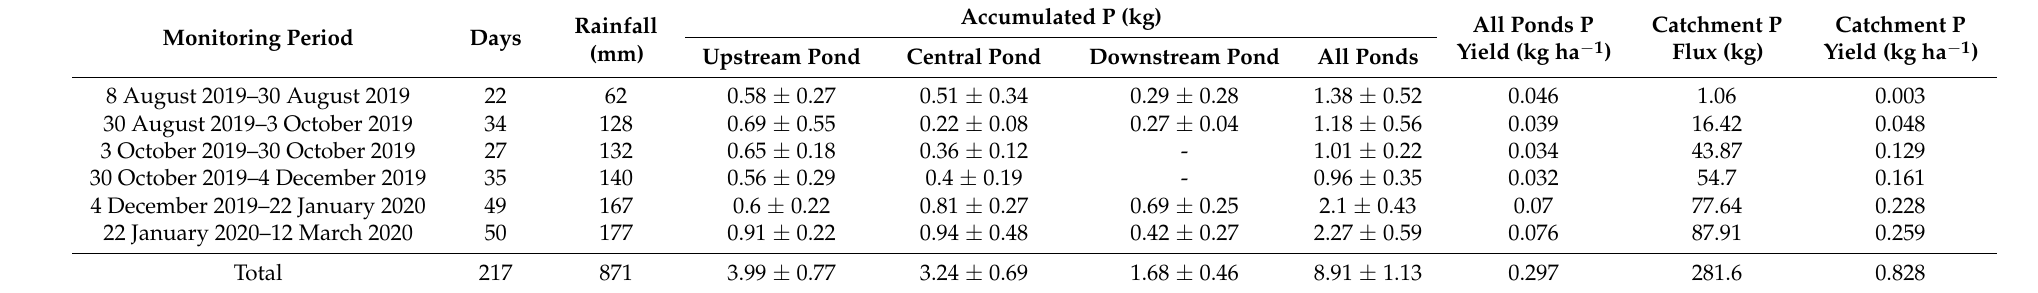
Table 5. Accumulated phosphorus ( ± SD) (kg) in each pond and all three ponds for sediment trap monitoring periods. Accumulated P yield (kg ha − 1 ) for all ponds from the